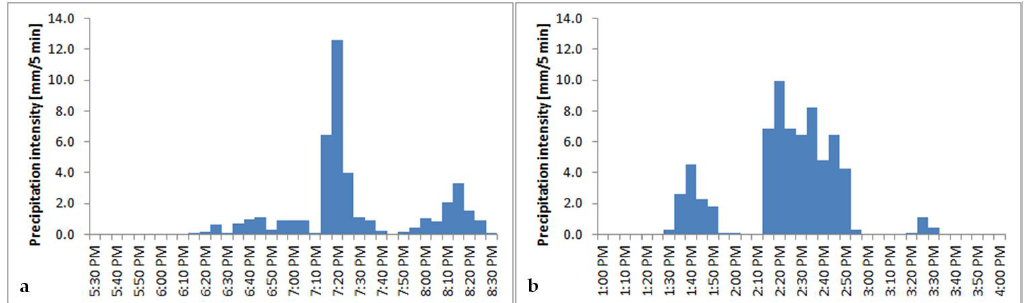
Figure 4. The storm events and its intensities for the RZ-product on ( a ) 23 and ( b ) 31 May 2016.